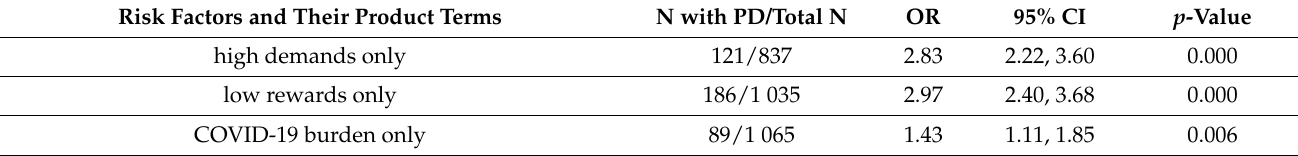
Table 3. Odds ratios of high demands, low rewards, and COVID-19 burden and their production terms from a binary logistic regression analysis of psychological distress on an individual level, with indices of additive (relative excess risk due to interaction)